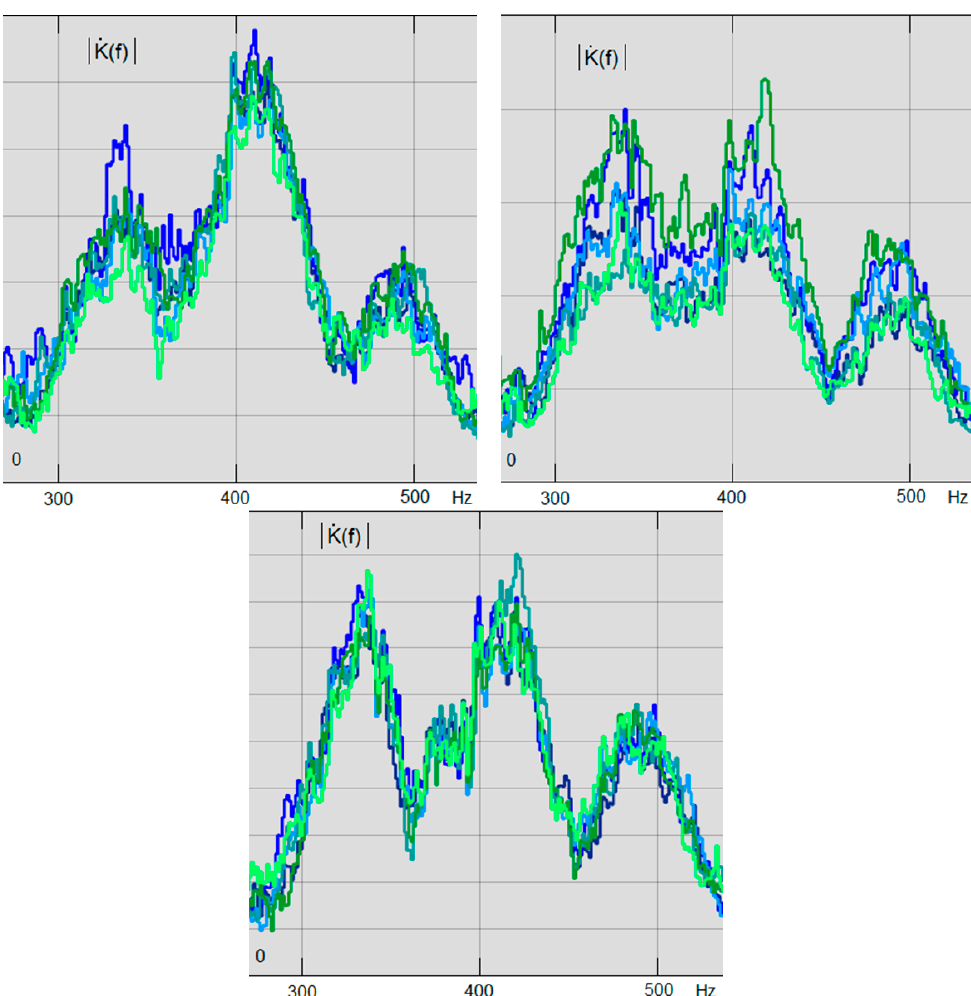
Figure 7. Dynamic of amplitude-frequency response of underwater acoustic channel for all three iterations of FM-OFDM-QPSK symbols transmission.